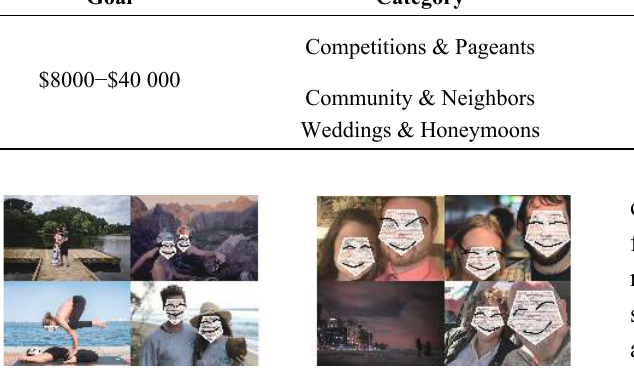
Fig. 8 Randomly selected photos from the successful (left) and unsuccessful (right)